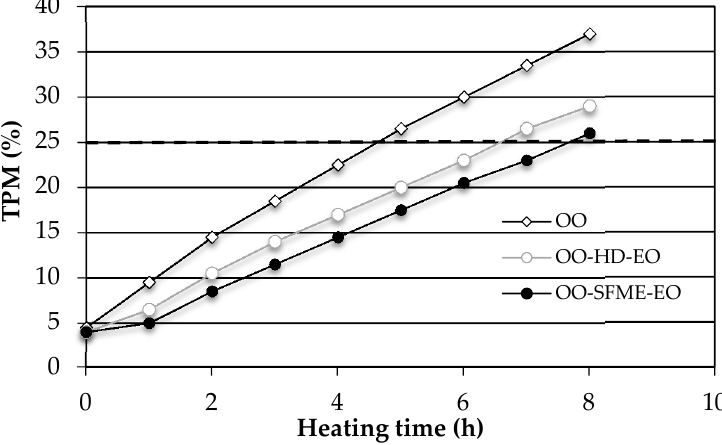
Figure 4. Comparison of TPM during the frying process (at 180 °C) of olive oil containing basil essential oils ( ● OO-SFME-EO; ○ OO-HD-EO) and virgin olive oil ( ◊ OO).